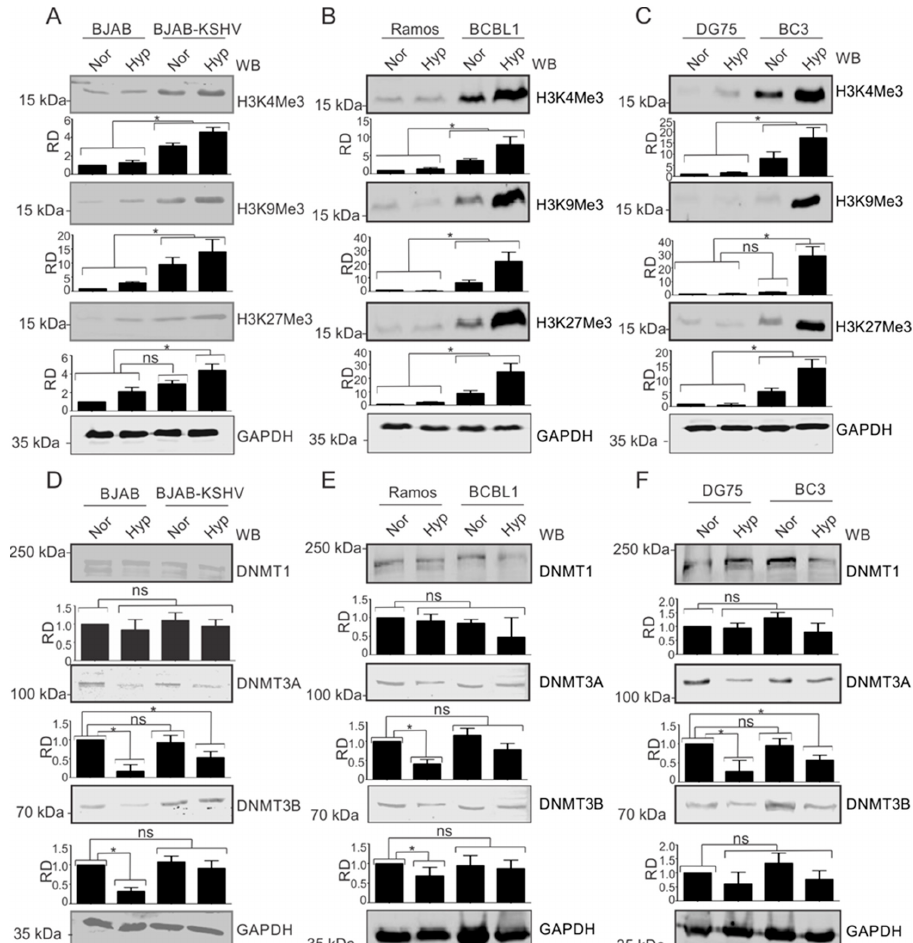
Figure 2. KSHV induces the expression of modified histone proteins. ( A ) Comparative analysis for levels of modified histone proteins in BJAB and BJAB-KSHV cells. Cells were grown either in normoxic or hypoxic conditions for 48 h. Equal amounts of proteins were used for analysis of the levels of H3K4Me3, H3K9Me3, and H3K27Me3 by Western Blotting. GAPDH served as loading control. ( B ) Comparative analysis for levels of modified histone proteins in KSHV-positive BCBL1 and KSHV-negative Ramos cells. Cells were grown either in normoxic or hypoxic conditions for 48 h. Equal amounts of proteins were used for analysis of the levels of H3K4Me3, H3K9Me3, and H3K27Me3 by Western Blotting. GAPDH served as the loading control. ( C ) Comparative analysis for levels of modified histone proteins in KSHV-positive BC3 and KSHV-negative DG75 cells. Cells were grown either in normoxic or hypoxic conditions for 48 h. Equal amounts of proteins were used for analysis of levels of H3K4Me3, H3K9Me3, and H3K27Me3 by Western Blotting. GAPDH served as a loading control. ( D ) Comparative analysis for levels of DNA modifying proteins in BJAB and BJAB-KSHV cells. Cells were grown either in normoxic or hypoxic condition for 48 h. Equal amounts of proteins were used for analysis of levels of DNMT1, DNMT3A, and DNMT3B by Western Blotting. GAPDH served as a loading control. ( E ) Comparative analysis for levels of modified histone proteins in KSHV-positive BCBL1 and KSHV-negative Ramos cells. Cells were grown either in normoxic or hypoxic conditions for 48 h. Equal amounts of proteins were used for analysis of levels of DNMT1, DNMT3A, and DNMT3B by Western Blotting. GAPDH served as loading control. ( F ) Comparative analysis for levels of modified histone proteins in KSHV-positive BC3 and KSHV-negative DG75 cells. Cells were grown either in normoxic or hypoxic conditions for 48 h. Equal amounts of proteins were used for analysis of levels of DNMT1, DNMT3A, and DNMT3B by Western Blotting. GAPDH served as a loading control (Nor = Normoxia, Hyp = Hypoxia). The p value of<0.05 was considered statistically significant. ns, not significant; * p